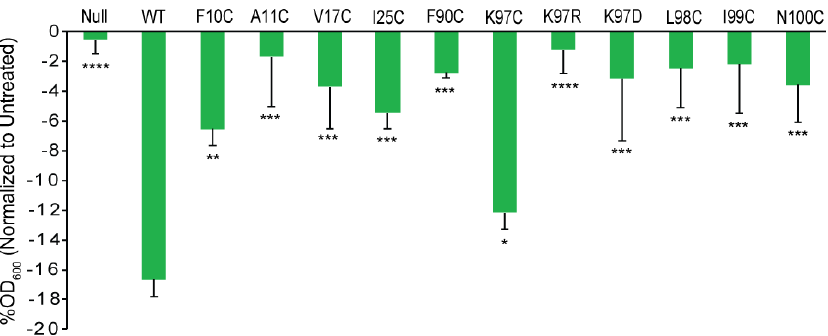
Figure 6. Mutational analysis provides additional evidence for the binding site of compound 262. The inhibition of growth after treatment of compound 262 at 40 µM is shown as OD 600 normalized to untreated cultures. The MJF455 ( Δ MscL and Δ MscS) cell lines carrying pB10d empty plasmid (Null) and expressing wild type E. coli MscL (WT) or mutations of E. coli MscL are indicated (n = 3–10). * p < 0.05, ** p < 0.005, *** p < 0.0005, **** p < 0.00005, mutations vs. WT for the E. coli MscL 2-tailed, homoscedastic t -test.